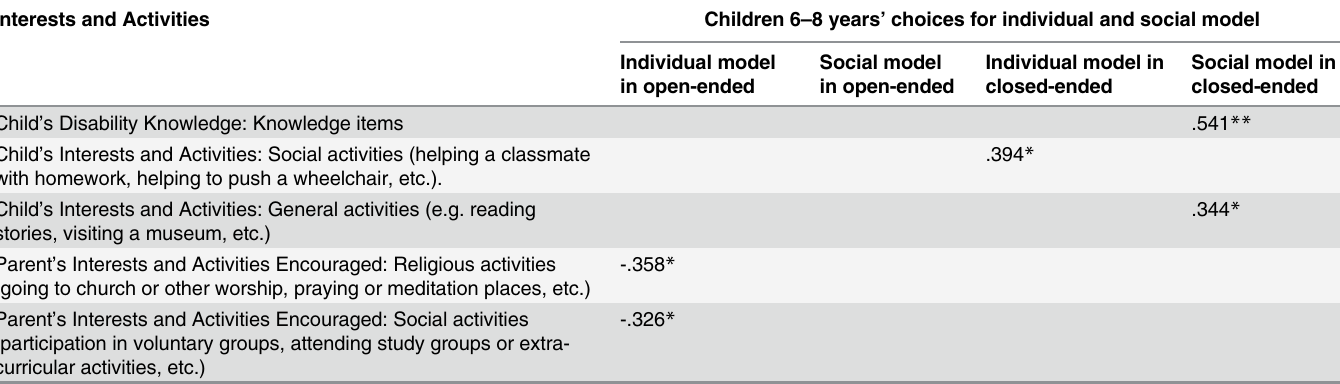
Table 1. Correlation between children 6 – 8 years ’ custom complex and their disability model choices. Interests and